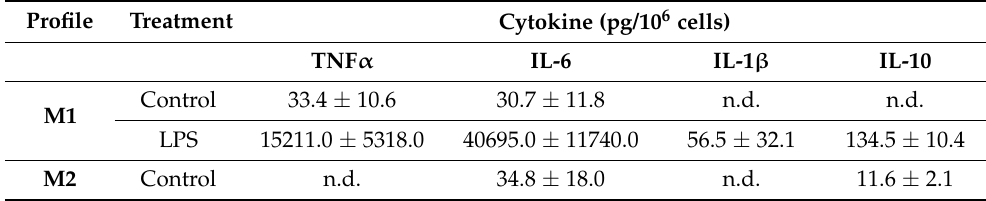
Table 1. Cytokine production induced in human monocyte-derived M1 and M2